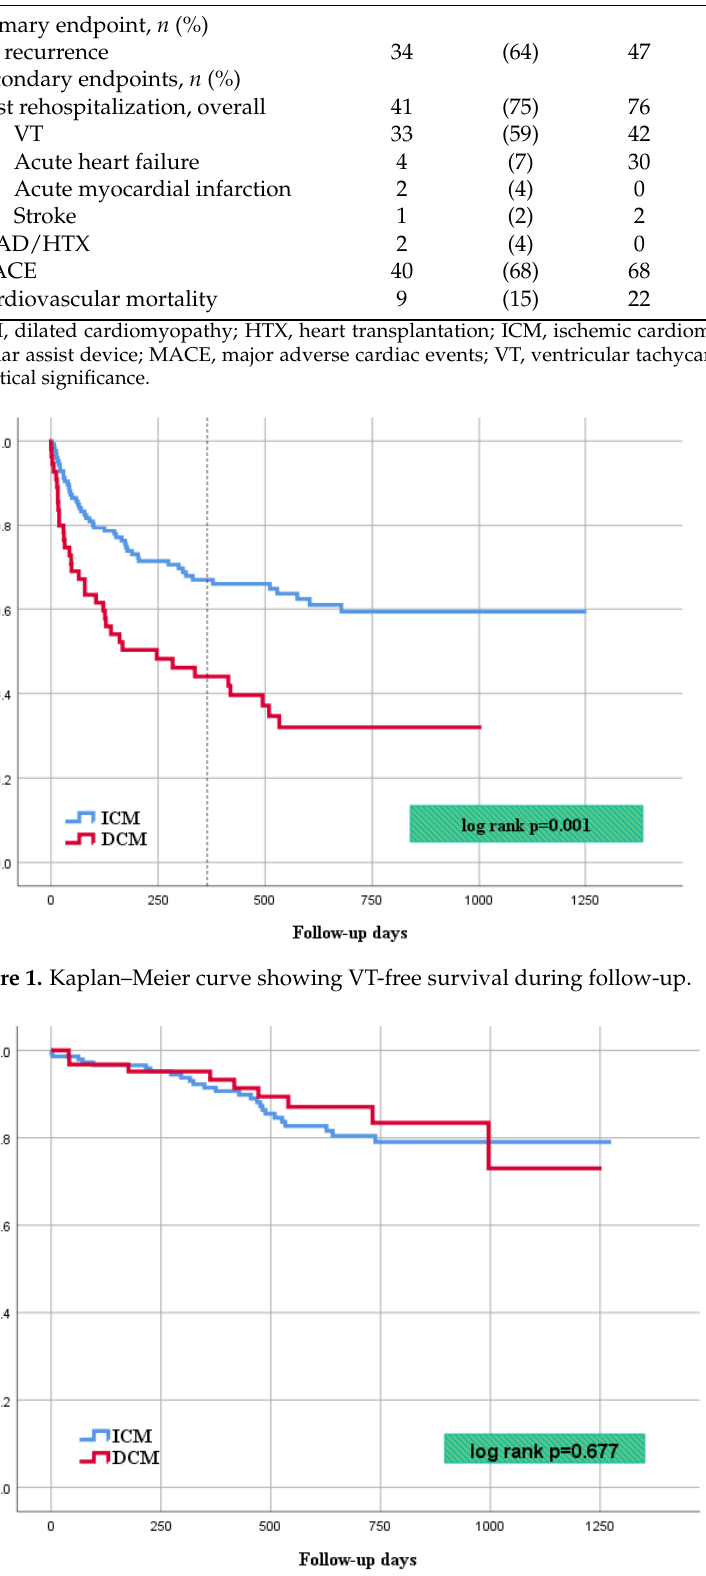
Figure 2. Kaplan–Meier curve showing survival rate after first catheter ablation for VT.